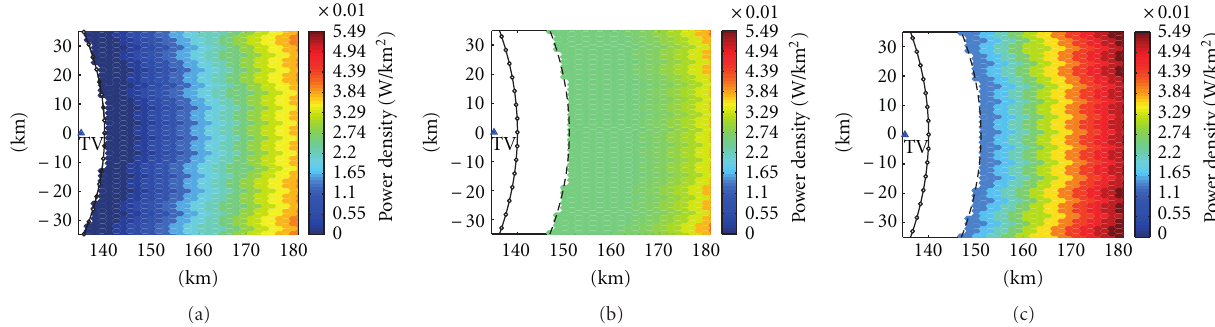
Figure 4: Spatial power density emitted from the secondary deployment area obtained by solving the optimization problem (12a)–(12c) when taking into account (a) only TV protection constraints (12b) with protection distance 0km, (b) both TV and secondary constraints (12b), (12c) with protection distance 11km, and (c) only TV protection constraints (12b) with protection distance 11km.